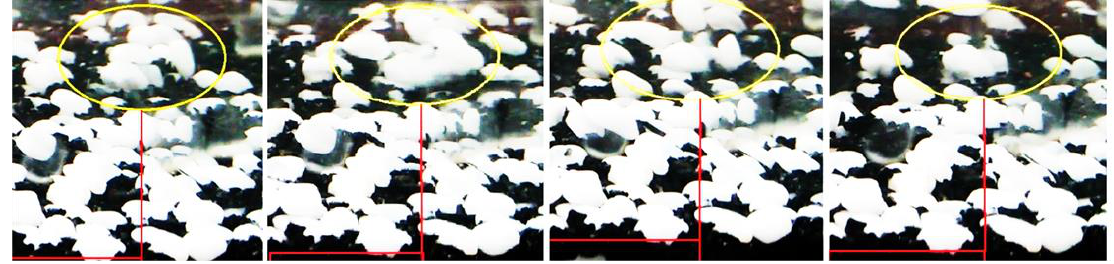
Figure 16. Sketches of the collapsing-mode process and the experimental evidence. The figure shows how the surrounding protection structure composed of coarse particles and fine particles gradually breaks as it is affected by the near-bed turbulence. The dashed red line in panel ( a ) indicates the turbulence-velocity process. When the fine particles represented by the little ball start to move away due to the turbulence effect, the coarse particle represented by the big ball begins to lose the support from fine particles and becomes unstable. Finally, the structure composed of coarse particles and fine particles collapses, as shown in panels ( a – d ) in order.